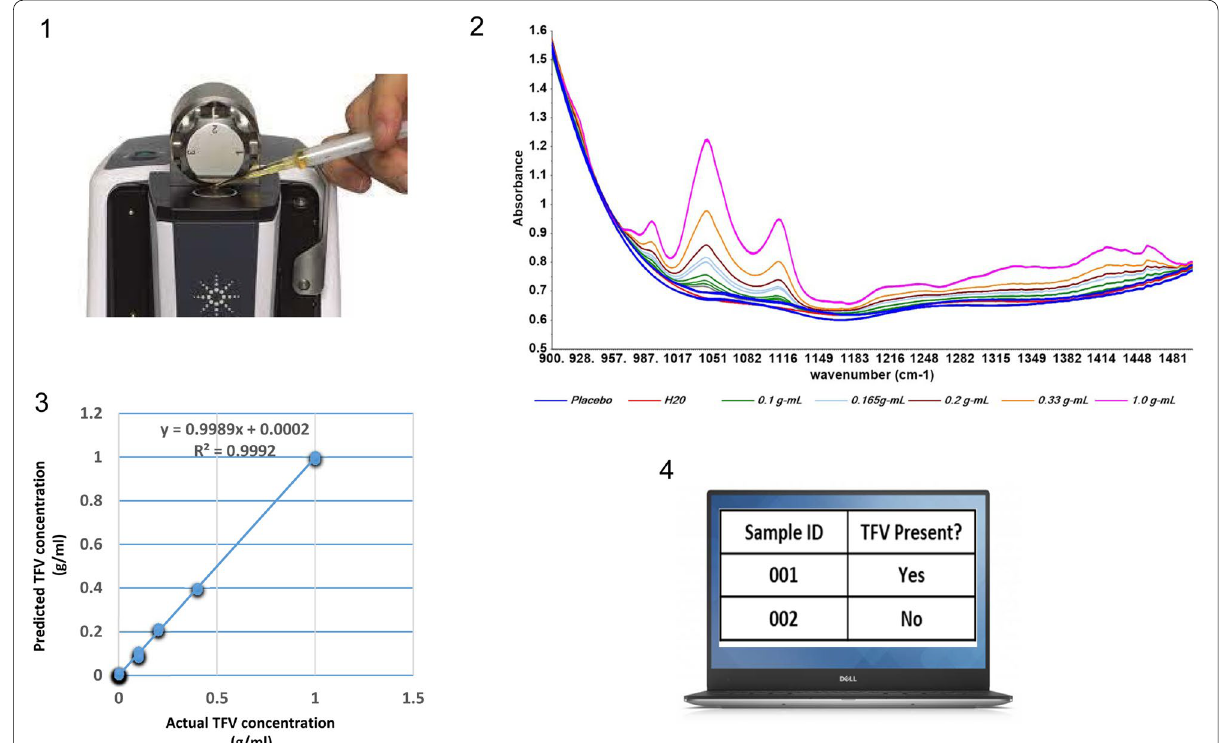
Fig. 2 Workflow to Determine Residual TFV on Gel Applicators Using FTIR Spectroscopy. Calibration samples, solutions of known amounts of TFV and placebo gel, are applied to the FTIR spectrometer (Step 1) to generate spectra from each sample (Step 2). The spectral data from the calibration samples are used to develop a discriminant algorithm for determining the presence of TFV in clinical samples (Step 3). Using this algorithm, vaginal swab extracts are placed on the spectrometer upon which a computer is programmed to generate a yes or no readout based on the algorithm prediction (Step 4).